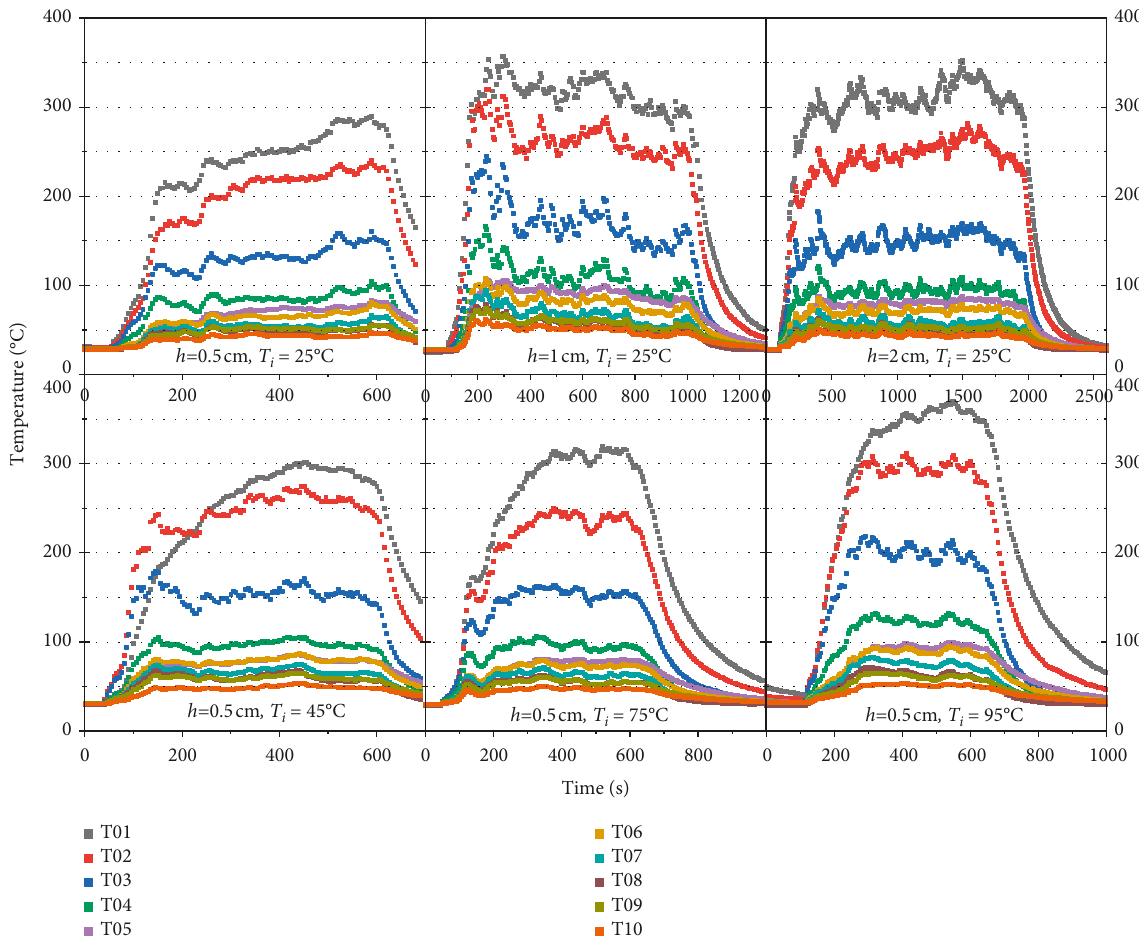
Figure 6: Fire plume temperature as a function of time under different experimental conditions.